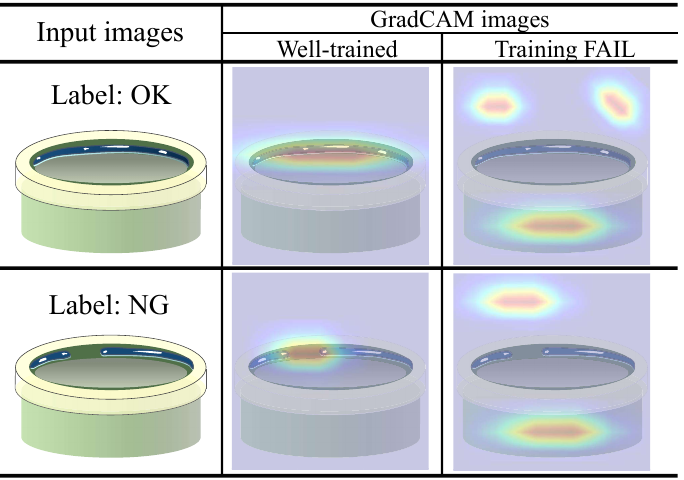
Figure 7. Grad-cam images of cylinder bonding. A warm color indicates high